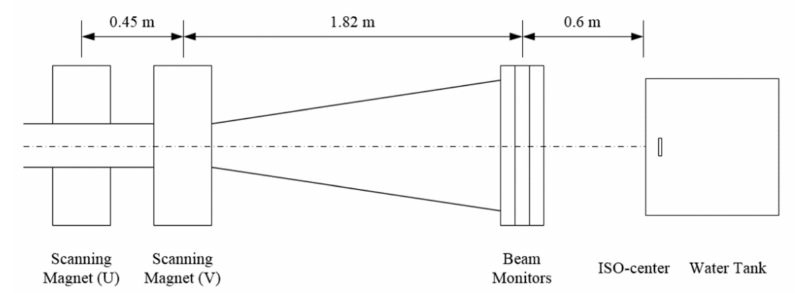
Figure 3. A simplified SAPT nozzle model for TOPAS simulation (not to